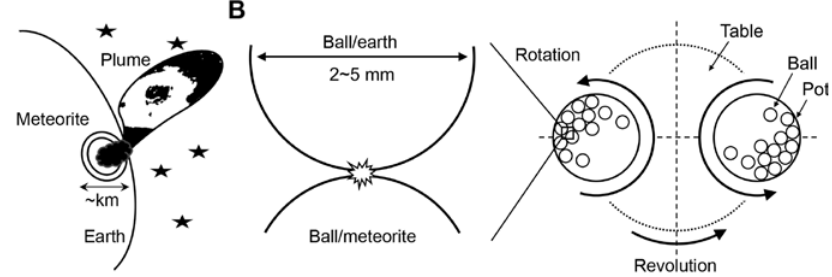
Figure 1: Schematic illustrations of (A) a meteorite impact and (B) a high-energy ball mill showing micro-impact